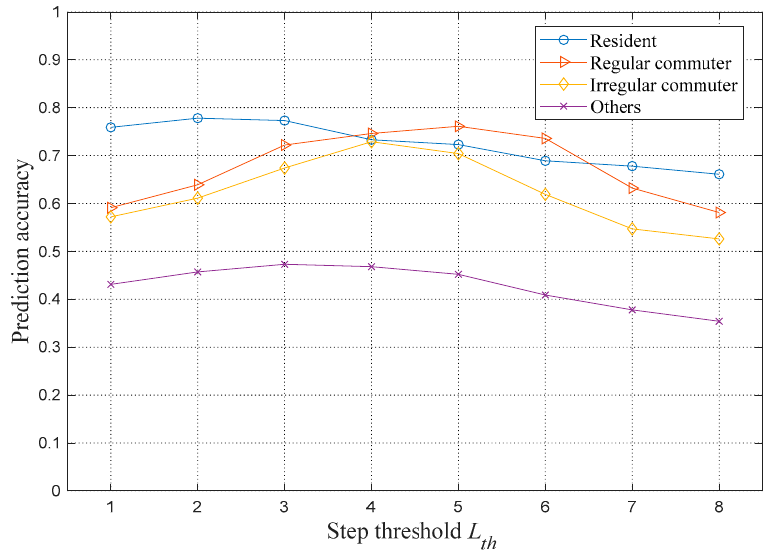
Figure 4. Relationship between the step threshold and the prediction accuracy.